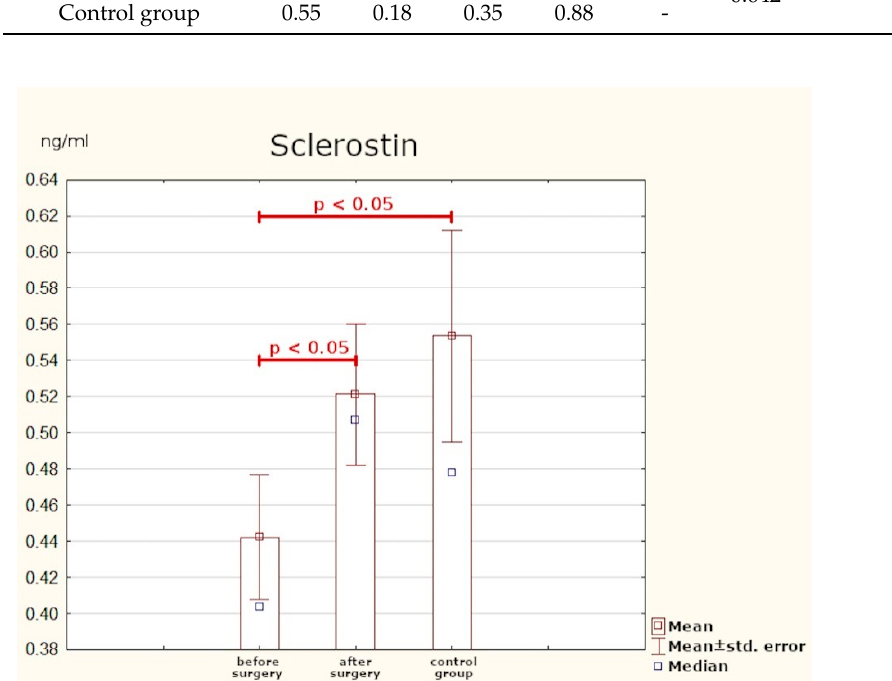
Figure 8. Serum concentrations of sclerostin.